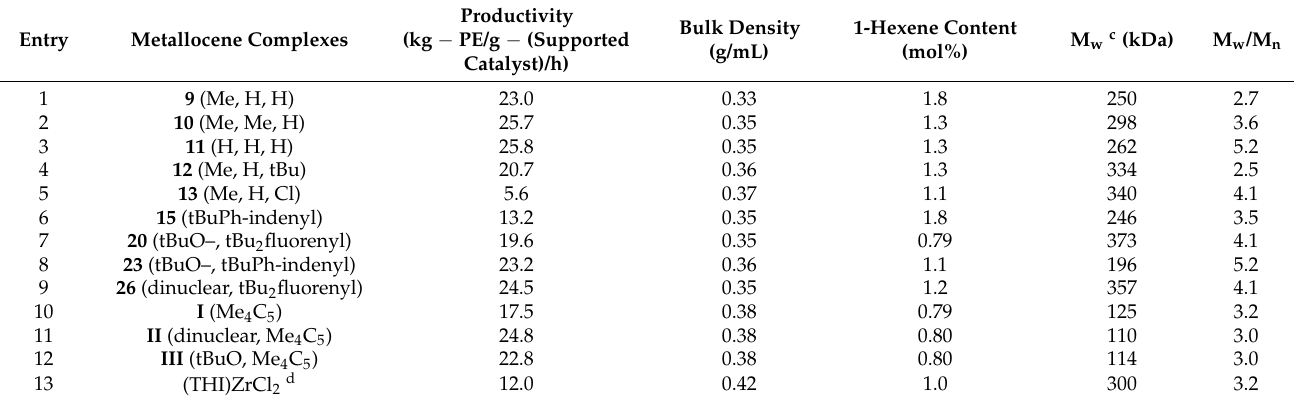
Table 1. Ethylene/1-hexene copolymerization results for the supported catalysts prepared with ansa -zirconocene complexes a,b